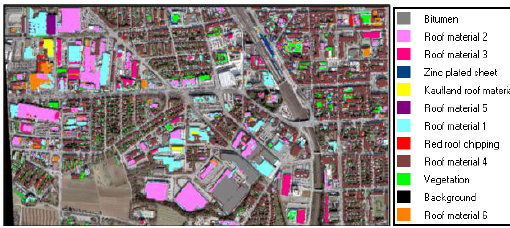
Figure 2: Overlay of classification map and orthoimage.